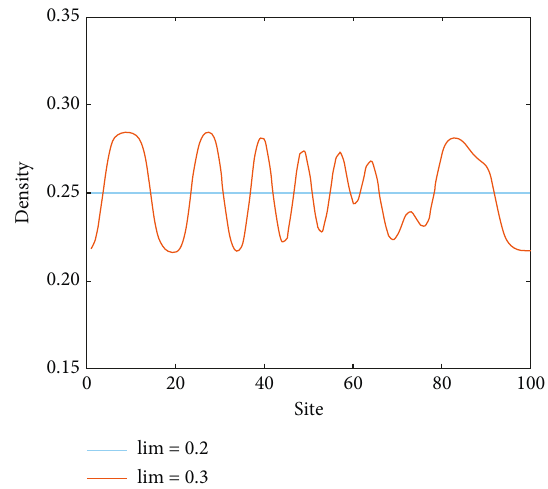
Figure 5: Cross-section view of the density wave with time under the action of different ρ lim